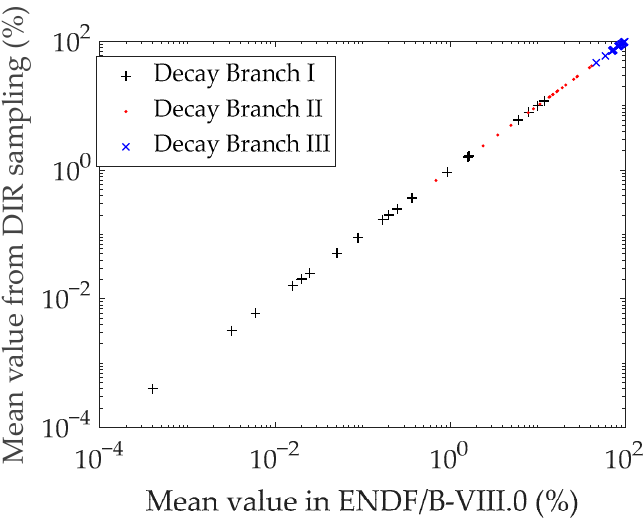
Figure 6. Comparison between suggested mean values in ENDF/B-VIII.0 and estimated mean values from DIR sampling method. (Black “+”, red “.”, and blue “×” are decay branches I, II, and III, re- spectively).